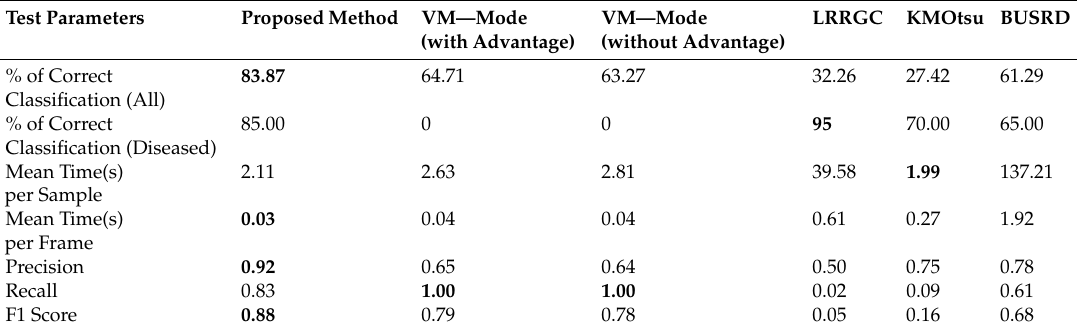
Table 1. Performance Comparison between Proposed method, VM-Mode [15], LRRGC [16], KMOtsu [29] and BUSRD [30] for the first dataset (bold indicates best